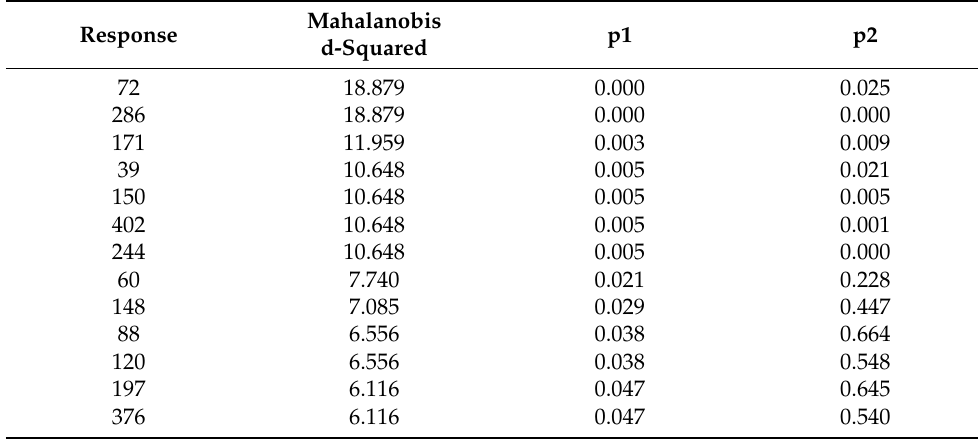
Table 2. Responses identified as